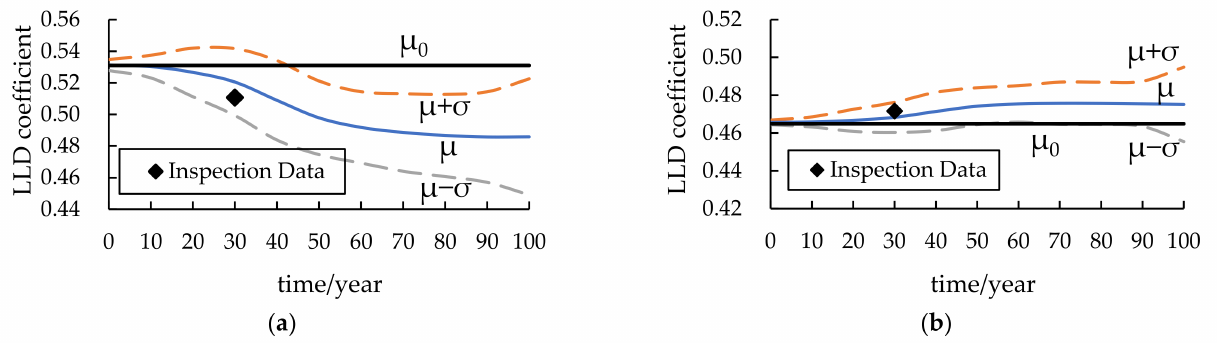
Figure 6. Time-dependent curves of mean value and standard deviation of LLD coefficients: ( a ) Beam 1; ( b ) Beam